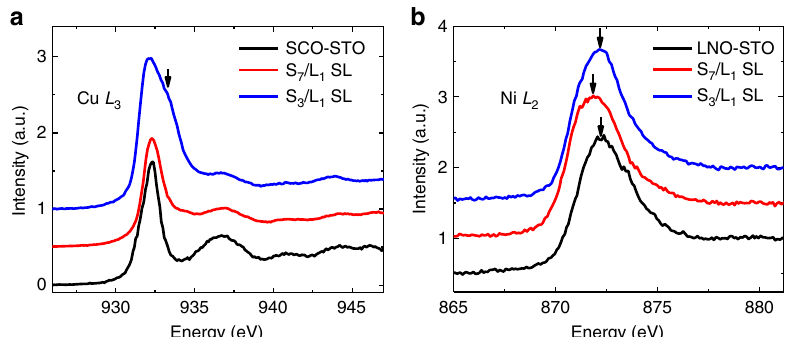
Fig. 4 The charge states of Cu and Ni in different superlattices. a X-ray absorption spectroscopy (XAS) of Cu L 3 -edge for a SrCuO 2 (SCO) fi lm and (SCO 7 /(LaNiO 3 ) 1 ) (noted as S 7 /L 1 ) and S 3 /L 1 superlattices (SL). A shoulder indicated by the black arrow arises from Cu d 9 L state. b XAS of Ni L 2 -edge for a LaNiO 3 (LNO) fi lm and S 7 /L 1 and S 3 /L 1 superlattices. A slight shift of the peak position to a lower energy for S 7 /L 1 superlattice suggests an electron doping in the LNO layer. The XAS is obtained by averaging linearly polarized XAS ( I = ( I ( σ ) + I (